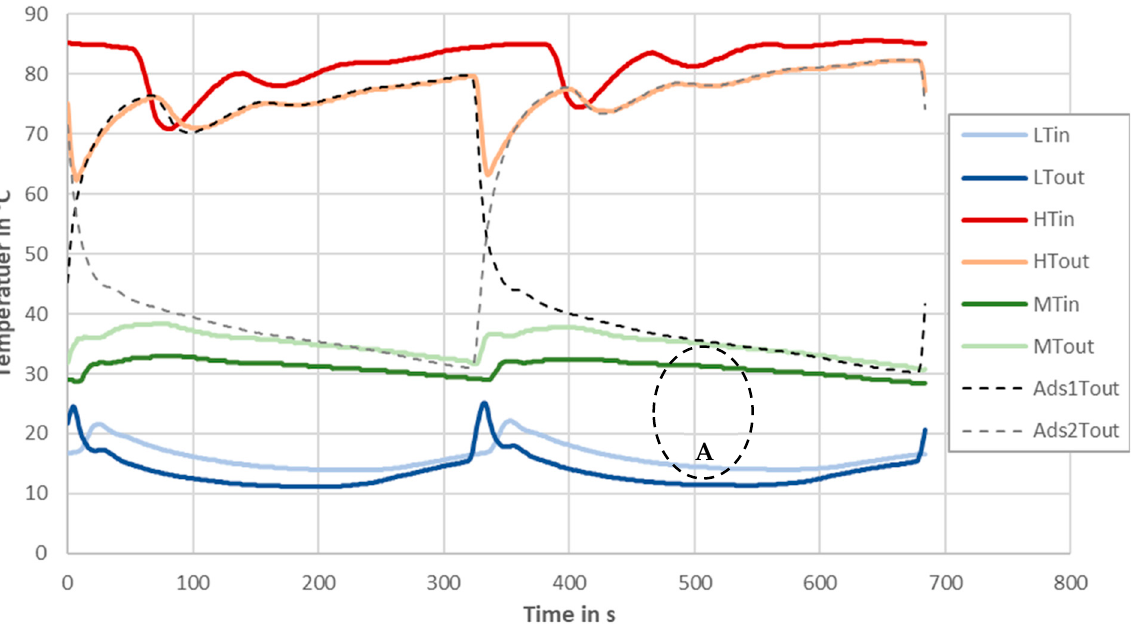
Figure 11. Example of a full cycle of the prototype. Inlet and outlet temperature evolutions of hot water, cooling water, chilled water and adsorbers.